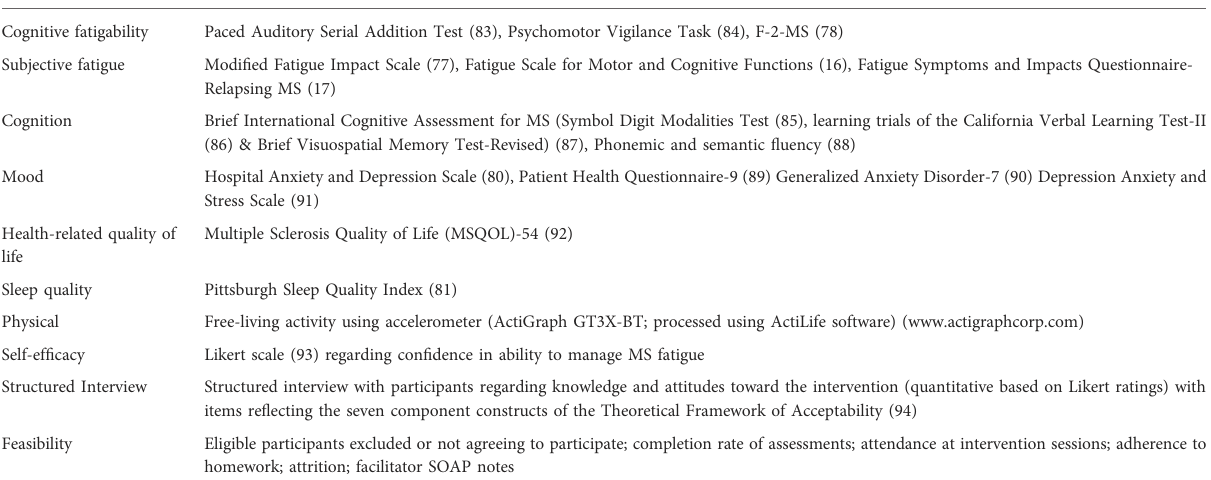
TABLE 3 Outcome measures for the behavioural intervention.